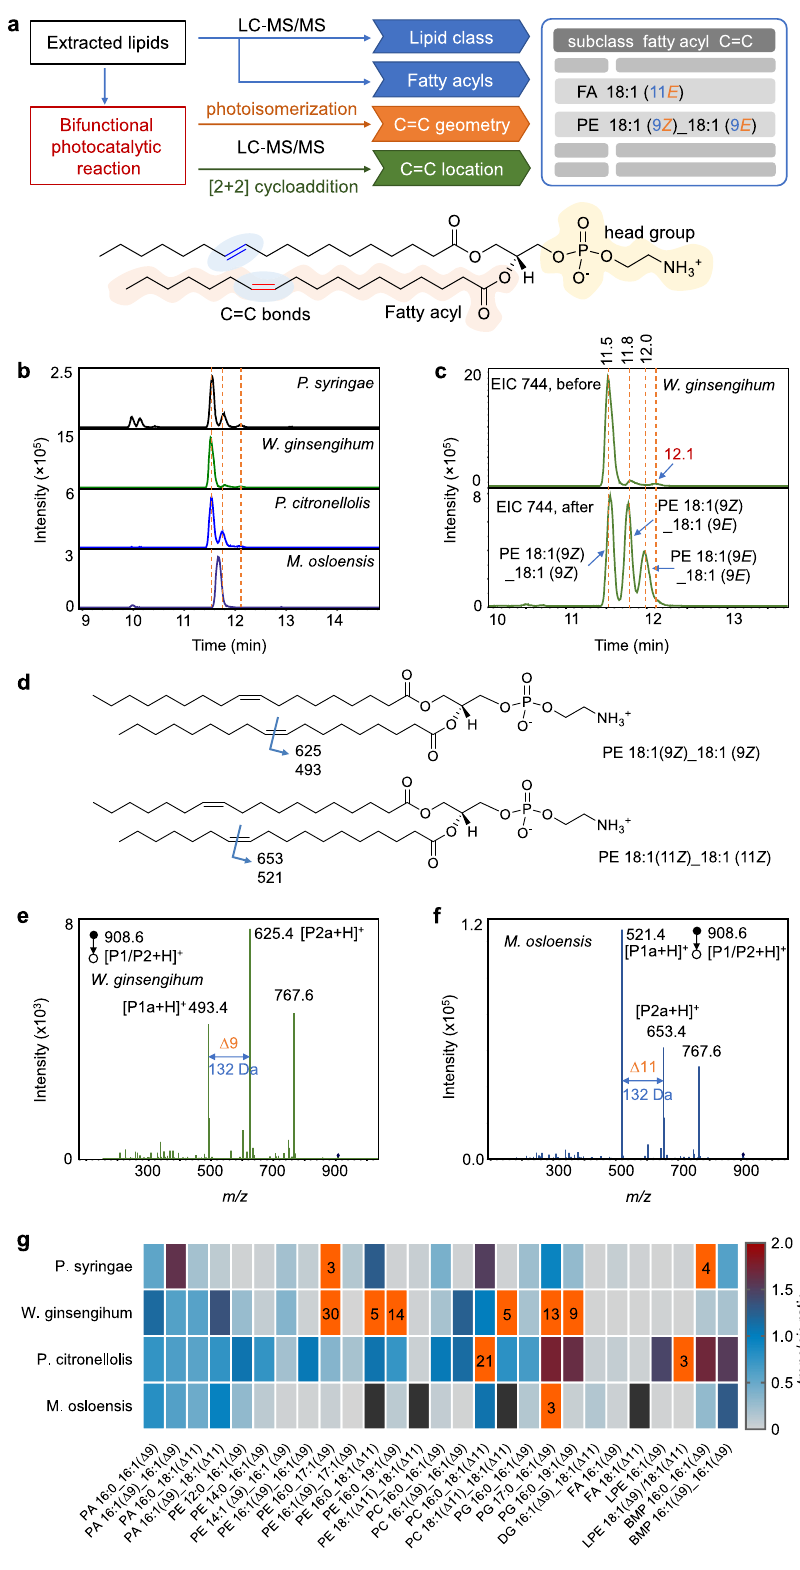
showed overall much more content of trans lipids, especially the phospholipids (Supplementary Table 2). For example, the trans - isomers of PAs are high in all four bacteria, the ratios are typically more than 50%. The ratios of trans -to- cis -isomers of